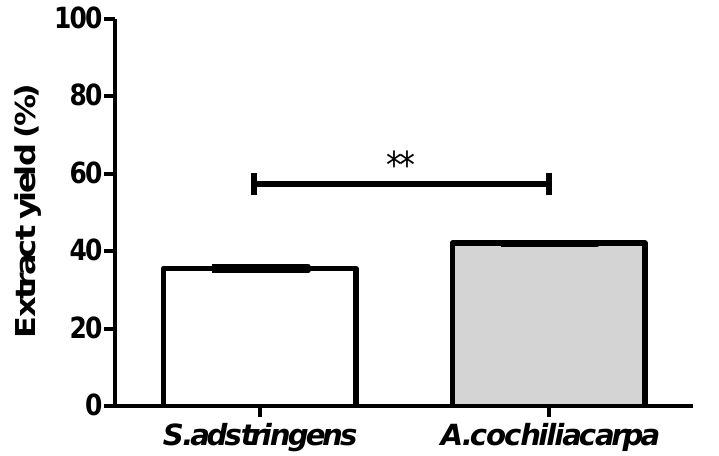
Figure 1. Yields of S. adstringens and A. cochliacarpa extracts showing a significant difference (** p < 0.05) using the t -Student test.